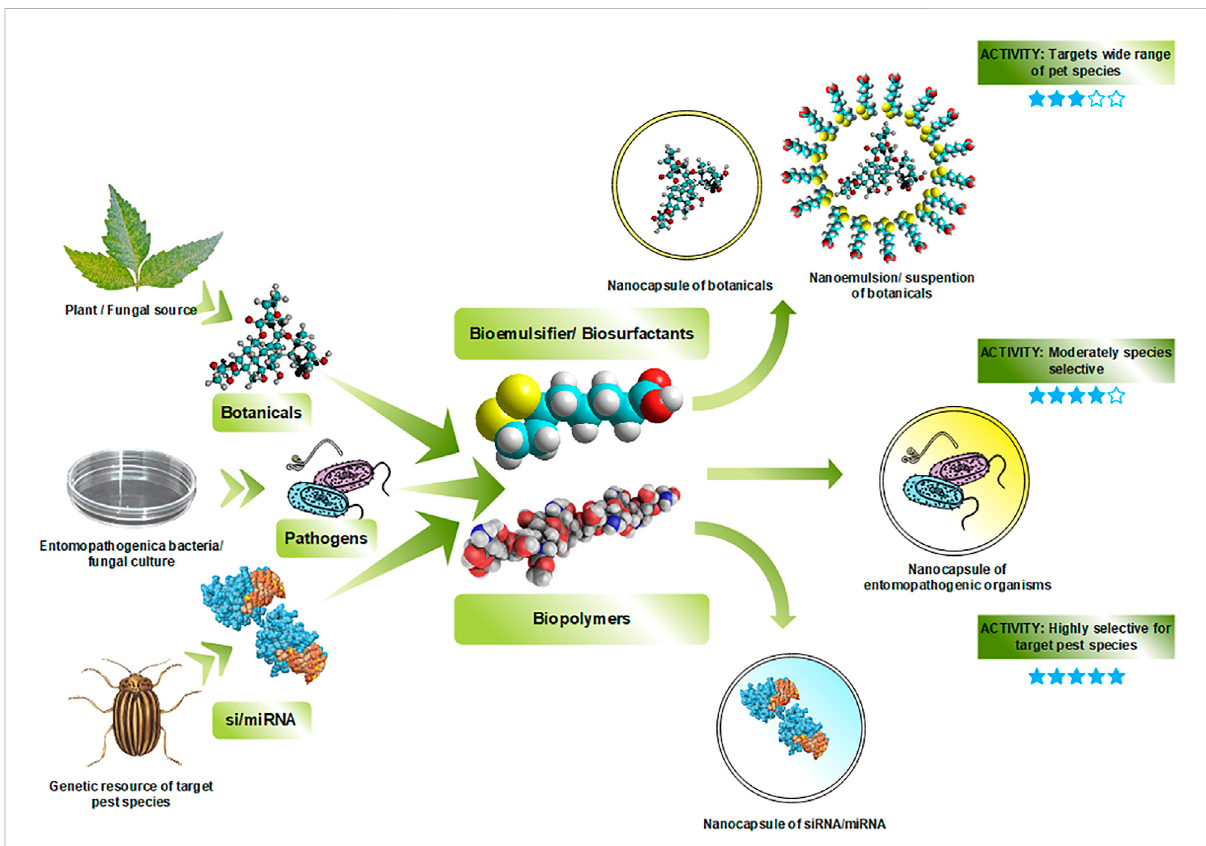
FIGURE 4 Schematic representation of synthesizing fully bio-nanoinsecticides employing both bioactive components/active ingredients (plant-based AI, microorganisms, and siRNA) and carrier/matrix materials (biopolymer) derived from natural